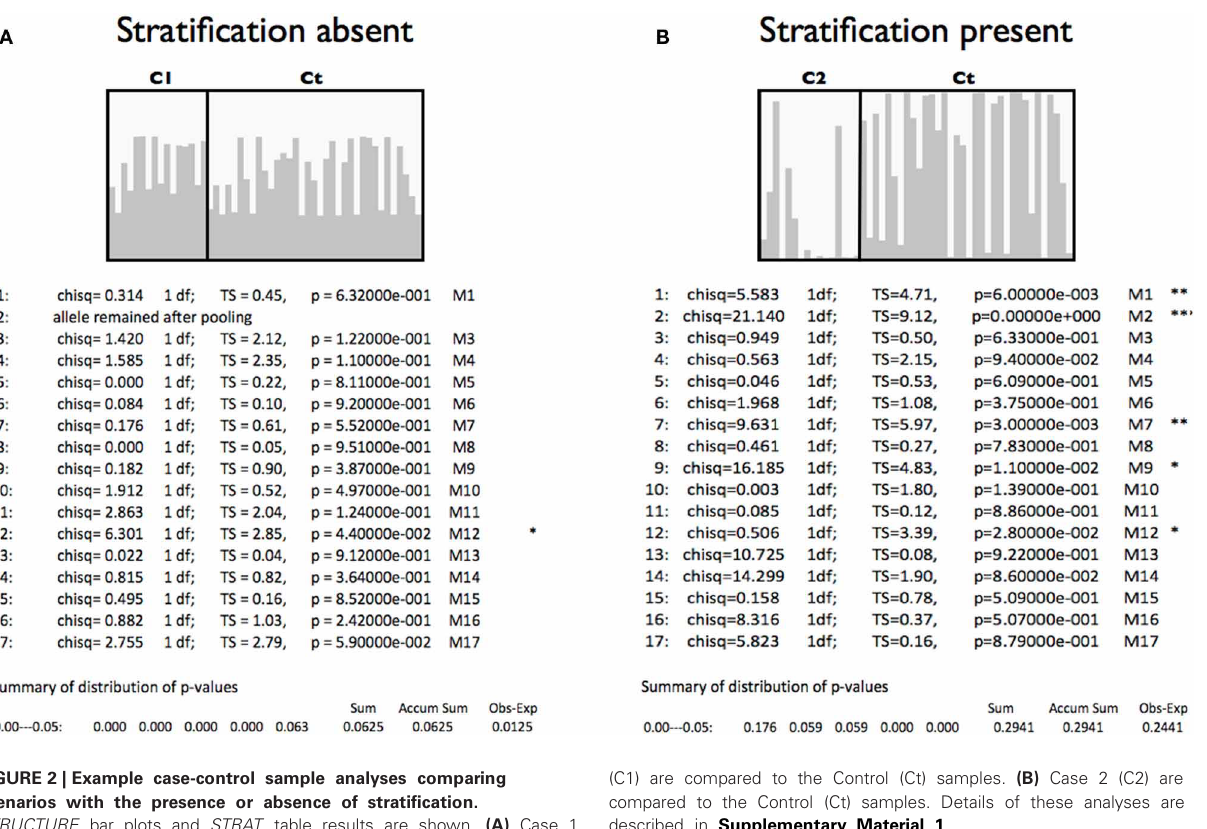
(C1) are compared to the Control (Ct) samples. (B) Case 2 (C2) are compared to the Control (Ct) samples. Details of these analyses are described in Supplementary Material 1